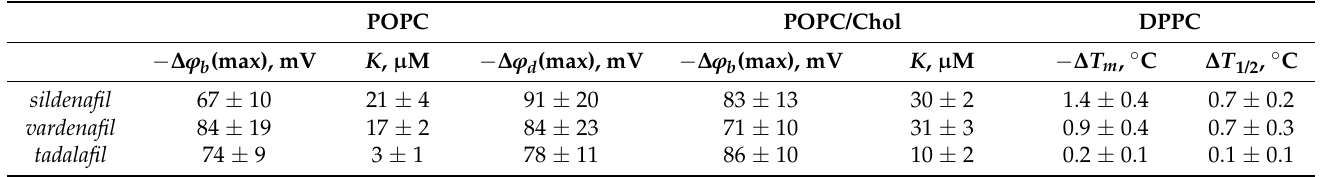
Table 2. The parameters characterizing the effects of PDE-5 inhibitors on the physicochemical properties of lipid bilayers. POPC POPC/Chol DPPC − ∆ ϕ − ∆ ϕ − ∆ ϕ b (max), mV K , µ M d (max), mV b (max),